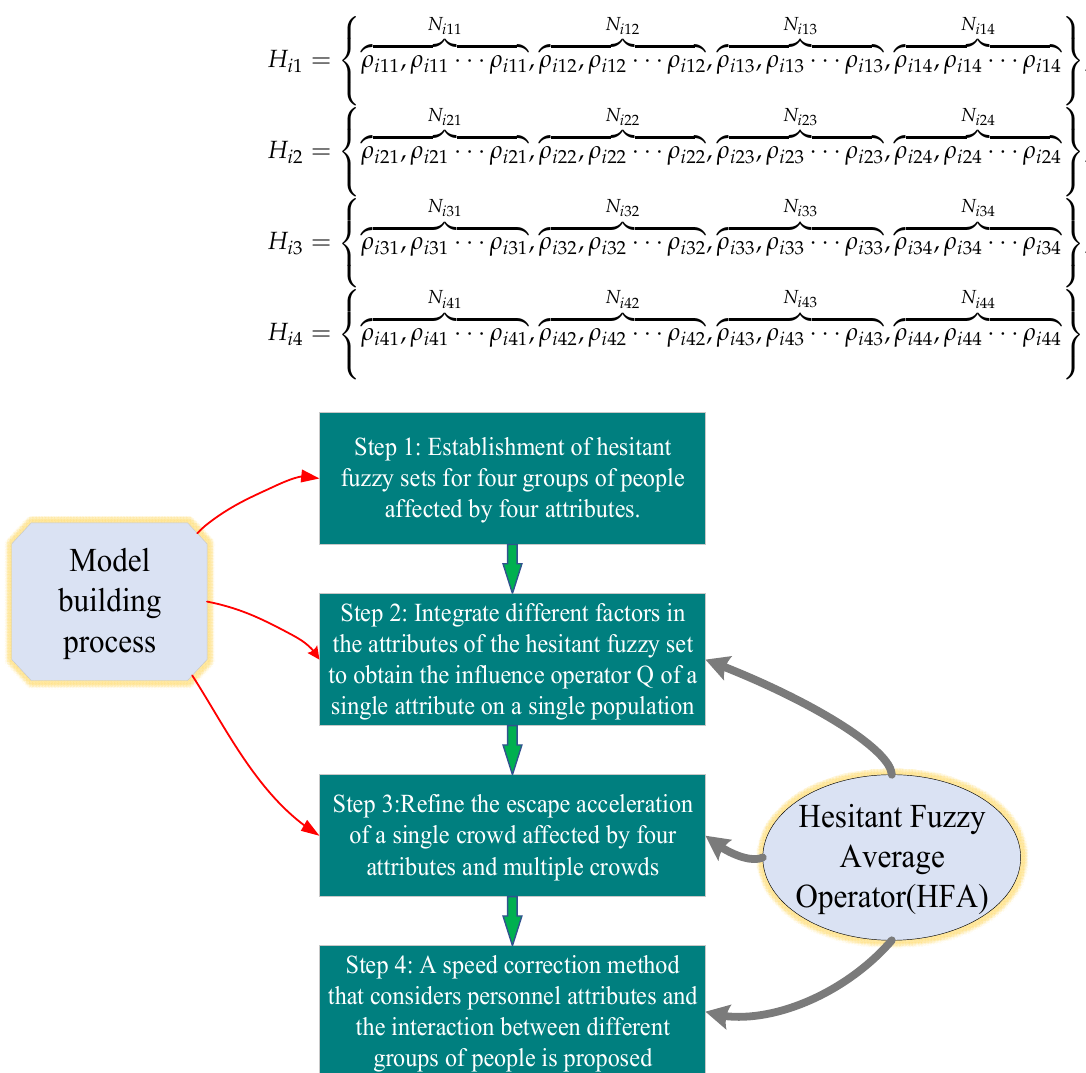
Figure 2. Model building